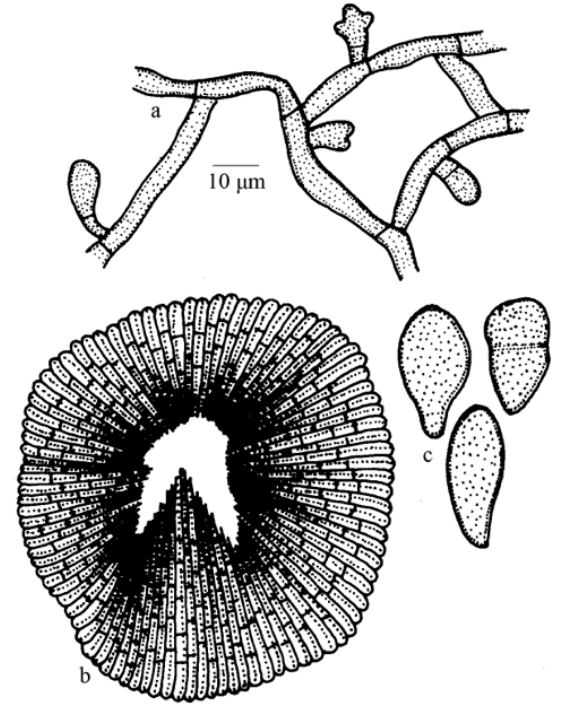
Figure 178. Asterostomella boehmeriae a - Appressoriate mycelium; b - Pycnothyrium; c - Pycnothyriospores